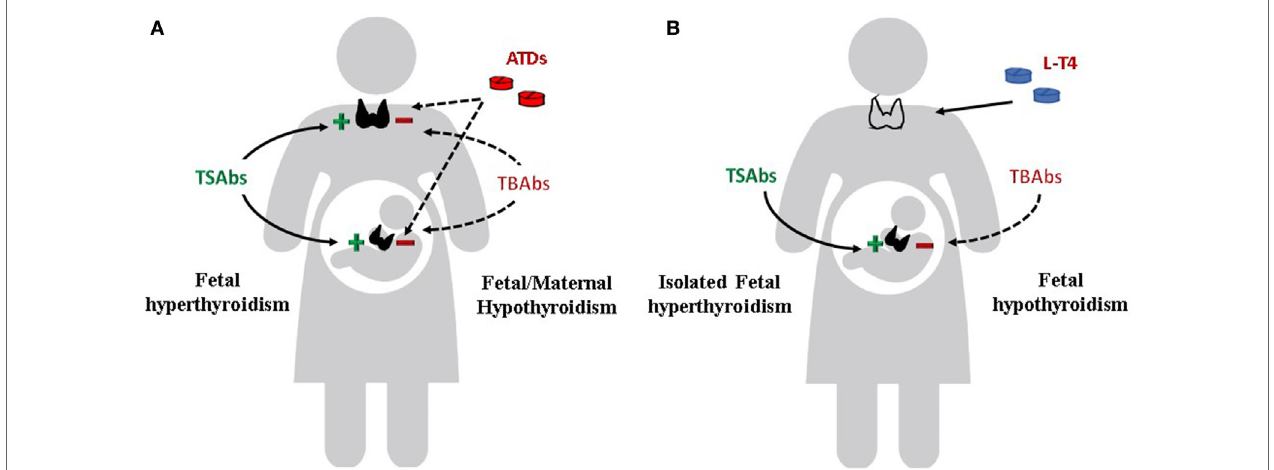
FiGURe 3 | Effects of TSH receptor antibodies and antithyroid drugs (ATDs) on maternal and fetal thyroid function. (A) Maternal and fetal thyroid are stimulated by TSAbs (continue line) and inhibited by ATDs and TBAbs (dotted line). If TBAbs are present, fetal as well as maternal hypothyroidism can occur. (b) Maternal hypothyroidism on L-T4 replacement after radioiodine therapy or thyroidectomy for Graves’ disease. Isolated fetal hyperthyroidism can occur. If TBAbs are present, fetal hypothyroidism can also